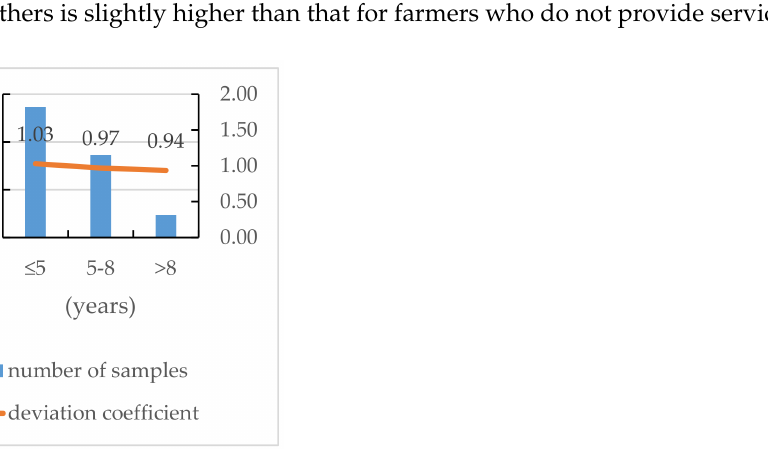
Figure 10. Deviation coefficient of agricultural machinery utilization rate grouped by years of service.